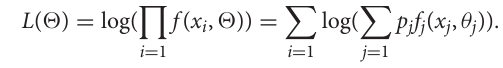
FIGURE 3 | Summary of the method of moments, (A) , and by the maximum likelihood estimation (MLE), (B) , of fitted distributions.